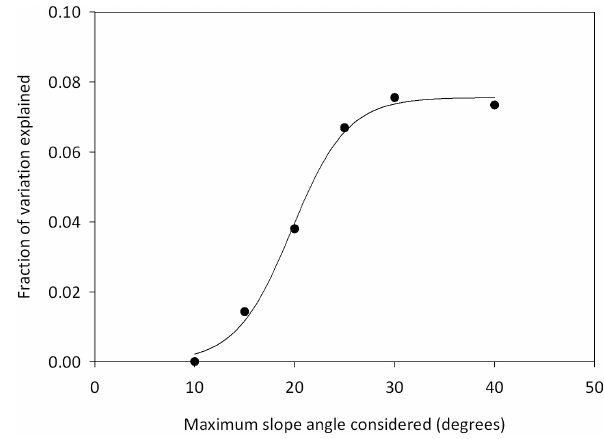
Fig. 6. Change in relative amount of carbon density variation ex- plained by slope angle as influenced by the maximum slope angle considered in the multiple regression model at 30-m pixel resolu-